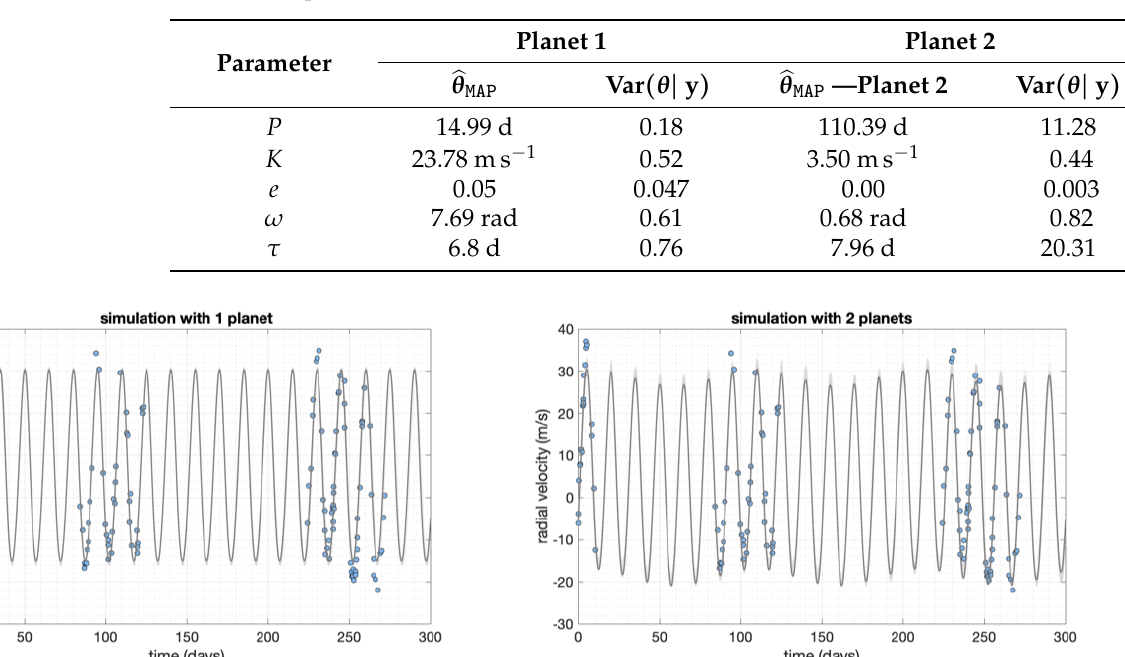
Table 4. The value of (cid:98) θ MAP and the variances of the marginal posteriors for the 2-planets model (with K = 120 data points).